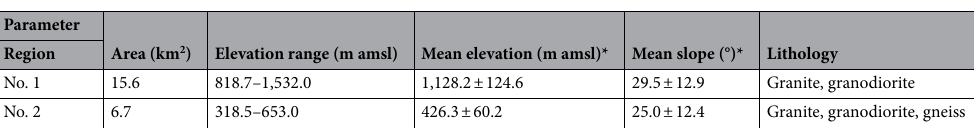
Table 1. Area, elevation, slope, and lithology of studied regions (for location, see Fig. 1). *Mean values with standard deviation.